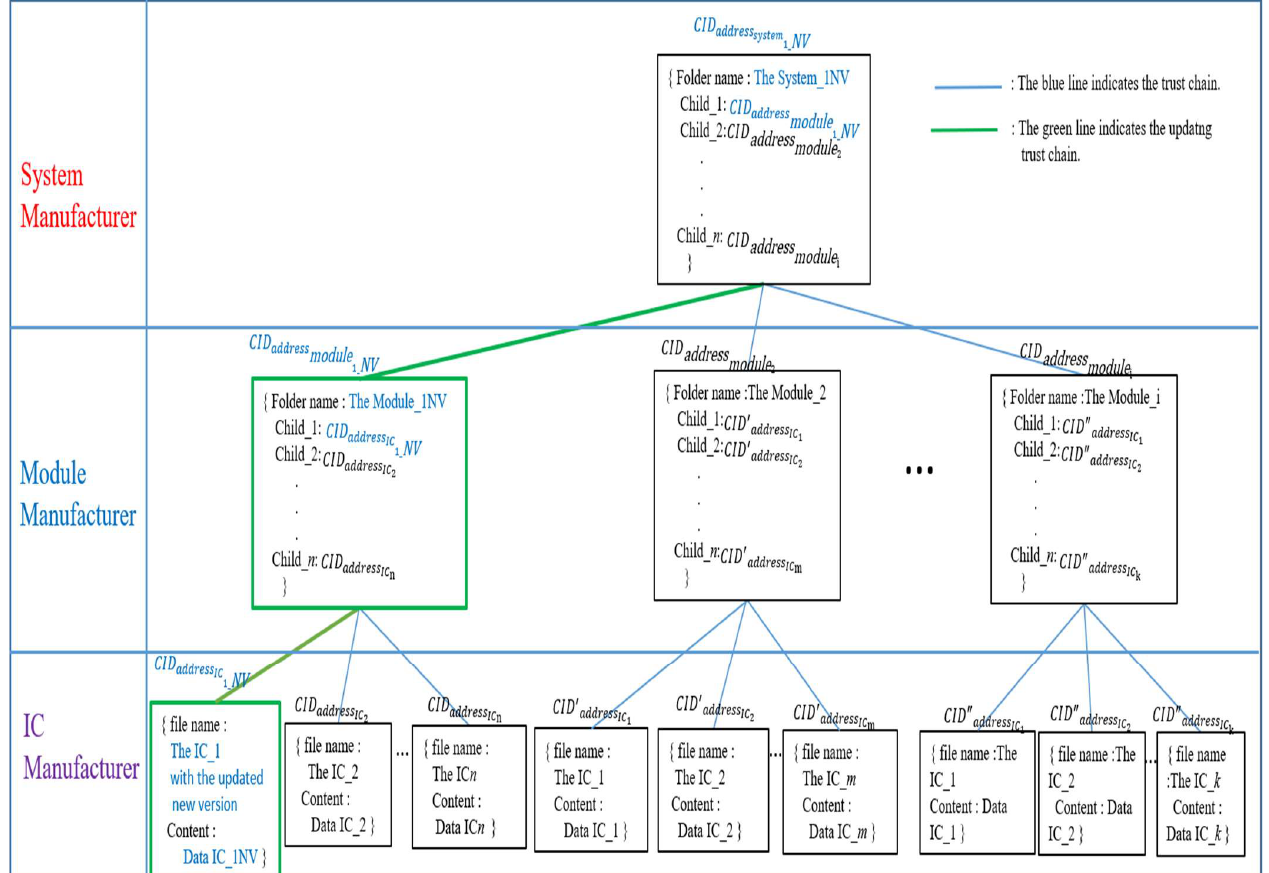
Figure 12. Merkle DAG in HCIDM performed in web-based DApp is activated and re-organized the trust chain in our framework when any version of IC, module, or system is updated.